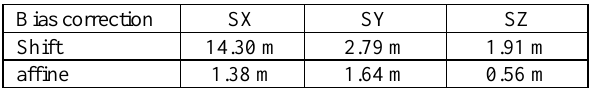
Table 9: Accuracy of Cartosat-1 3-D-orientation at 32 GCPs The three-dimensional orientation confirms the problems with affinity deformation of the Cartosat-1 scenes. Only the result based on bias correction by affinity transformation can be